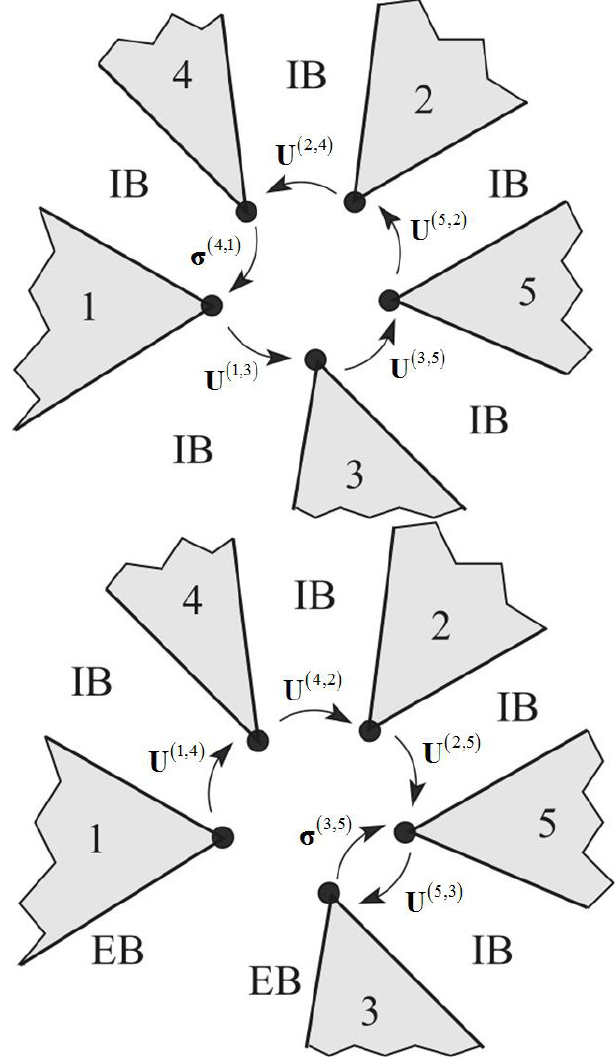
Figure 7: Multiple corner boundary conditions schemes: a)